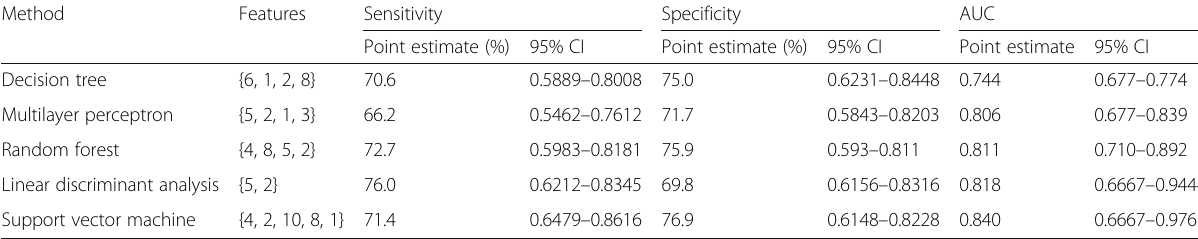
Table 7 Performance of five different machine learning methods for classifying 206 solid breast lesion on ultrasound images